Question: Compose a caption that would accompany this figure in a paper.
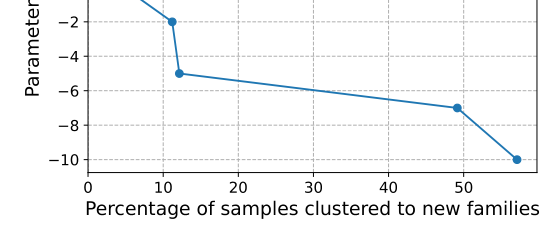
Answer: The relationship between the parameter τ and the percentage of streaming data clustered to new malware families.